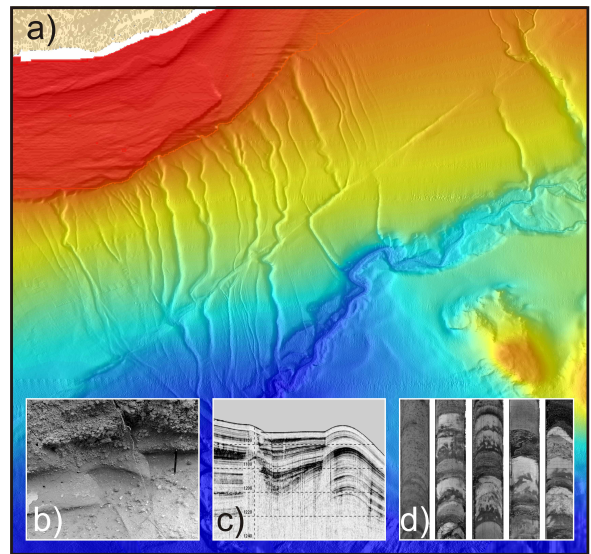
Fig. 3. Figure illustrating the different data and common meth- ods used in marine and lake paleoseismology. (a) Colour shaded- relief bathymetric map; (b) Complementary data from outcrops and trenches onshore; (c) High-resolution marine seismic profile; (d) Deep-sea sediment core sections. See text for additional informa-